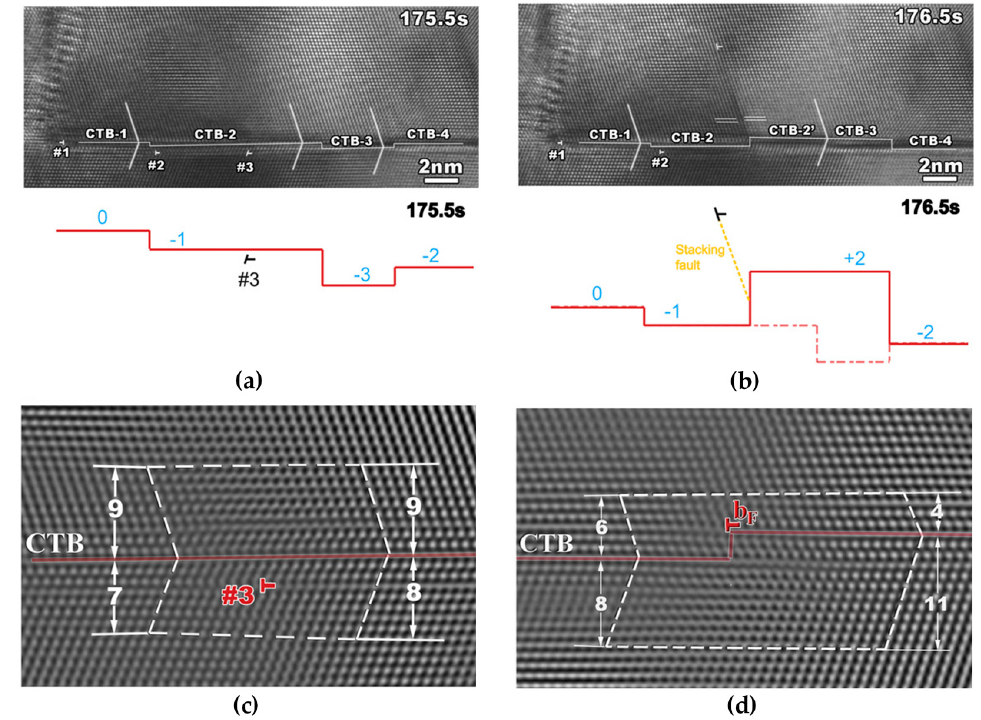
Figure 18. HREM images and illustrations of dislocation transmission leaving residual dislocations and forming steps on the coherent twin boundary. ( a , c ) Images and illustration before transmission; ( b , d ) Images and illustration after transmission. (Reprinted from Reference [106], with permission from Elsevier).